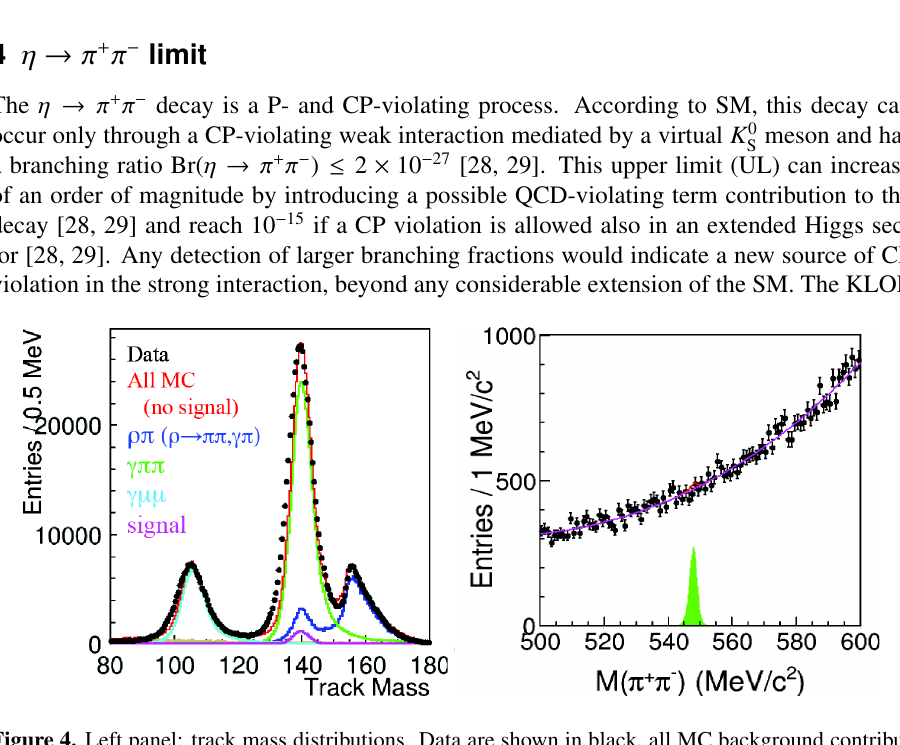
Figure 4. Left panel: track mass distributions. Data are shown in black, all MC background contribu- tions in the hypothesis of no η → π + π − signal are in red ( ρπ in blue, γπ + π − in green, γµ + µ − in cyan), while the signal is shown in violet. Right panel: π + π − invariant mass distribution for data (black points). The curve is a third polynomial function with superimposed a MC signal shape in arbitrary